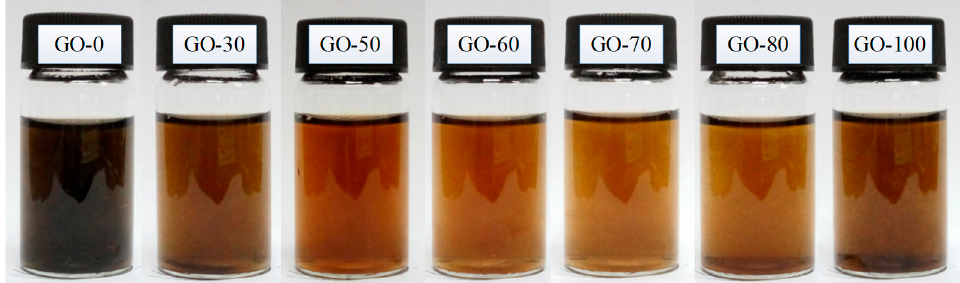
Figure 1 Color change of the graphite oxide dispersion prepared at different reaction temperatures.